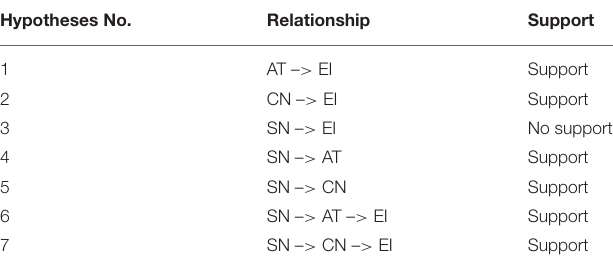
TABLE 6 | Results of the empirical support of the hypotheses. Hypotheses